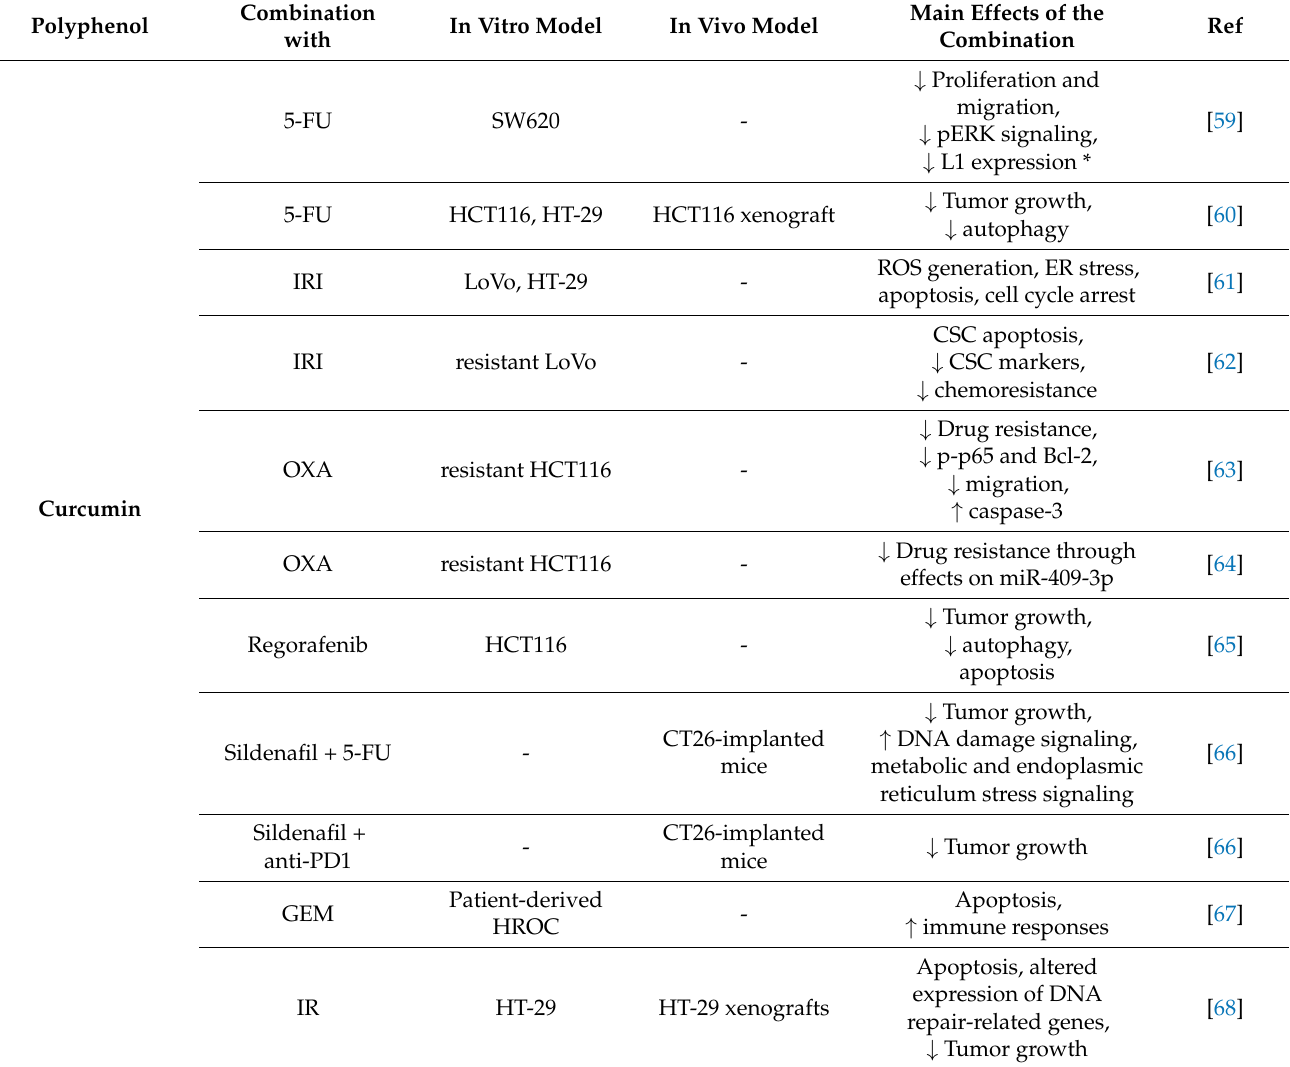
Table 1. Preclinical studies on the effects of dietary polyphenols in combination with standard or experimental CRC treatments.